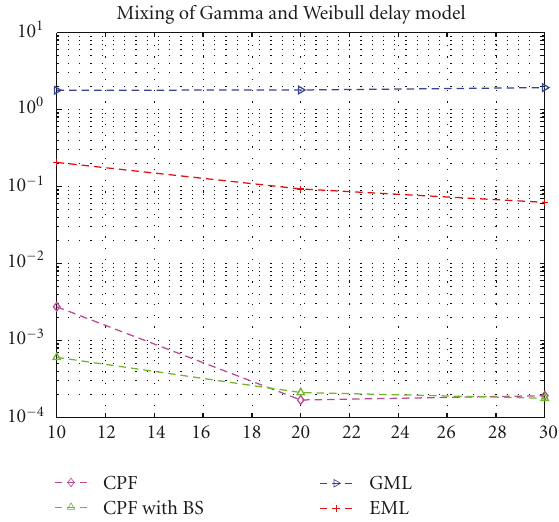
Figure 10: MSEs of clock o ff set estimators for mixing of Gamma = 5 and α = 2, β = 2] and Weibull [ α [ α 1 = 2, β 2 2 1 = 2] and 2 exchange message errors and α 2 = 6, β 2